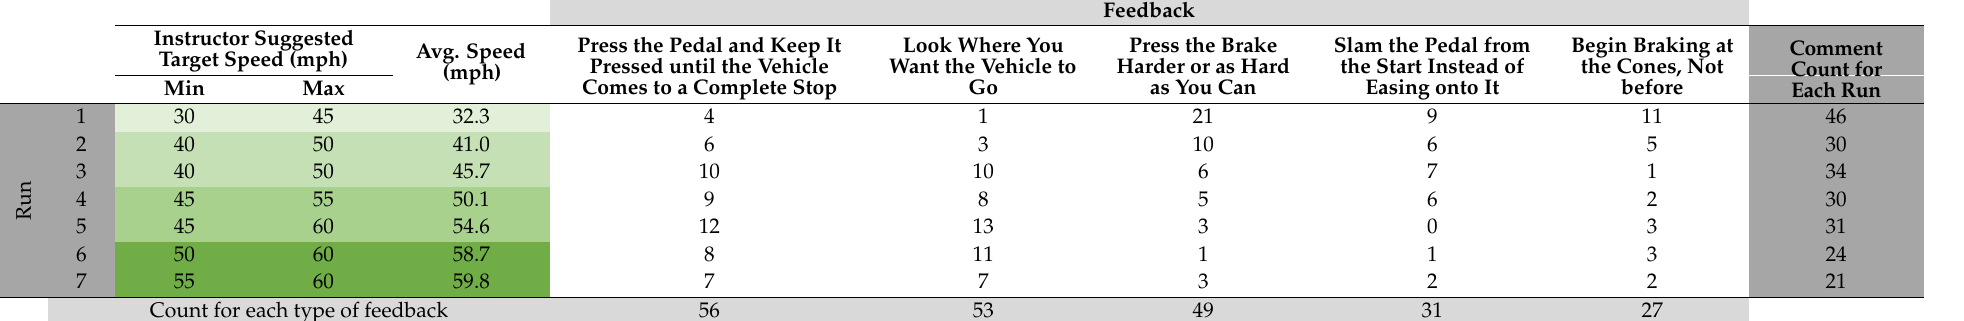
Table 6. Feedback given to drivers during each